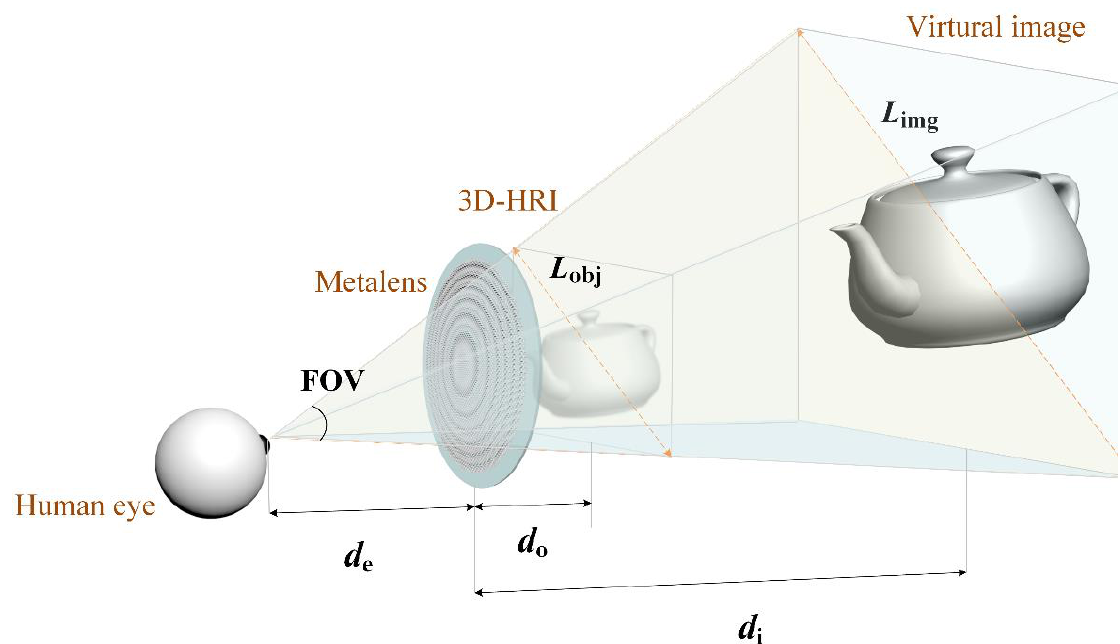
Figure 1. Schematic illustration of the proposed MCGH-NED system. An enlarged virtual image can be viewed by the human eye after placing the transparent HRI in front of the metalens eyepiece.